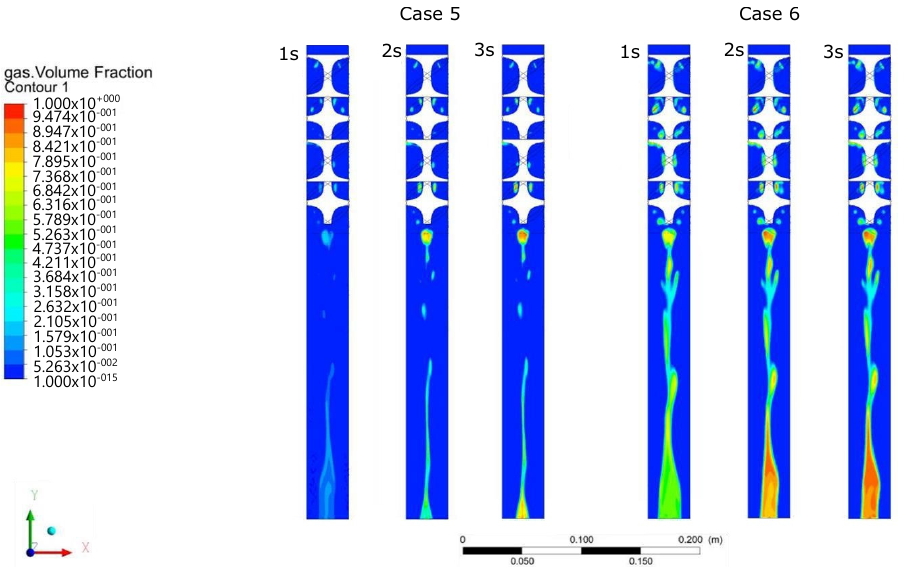
Figure 7. Gas distribution in the multiphase mixture. The concentration at the center of the pipe can be